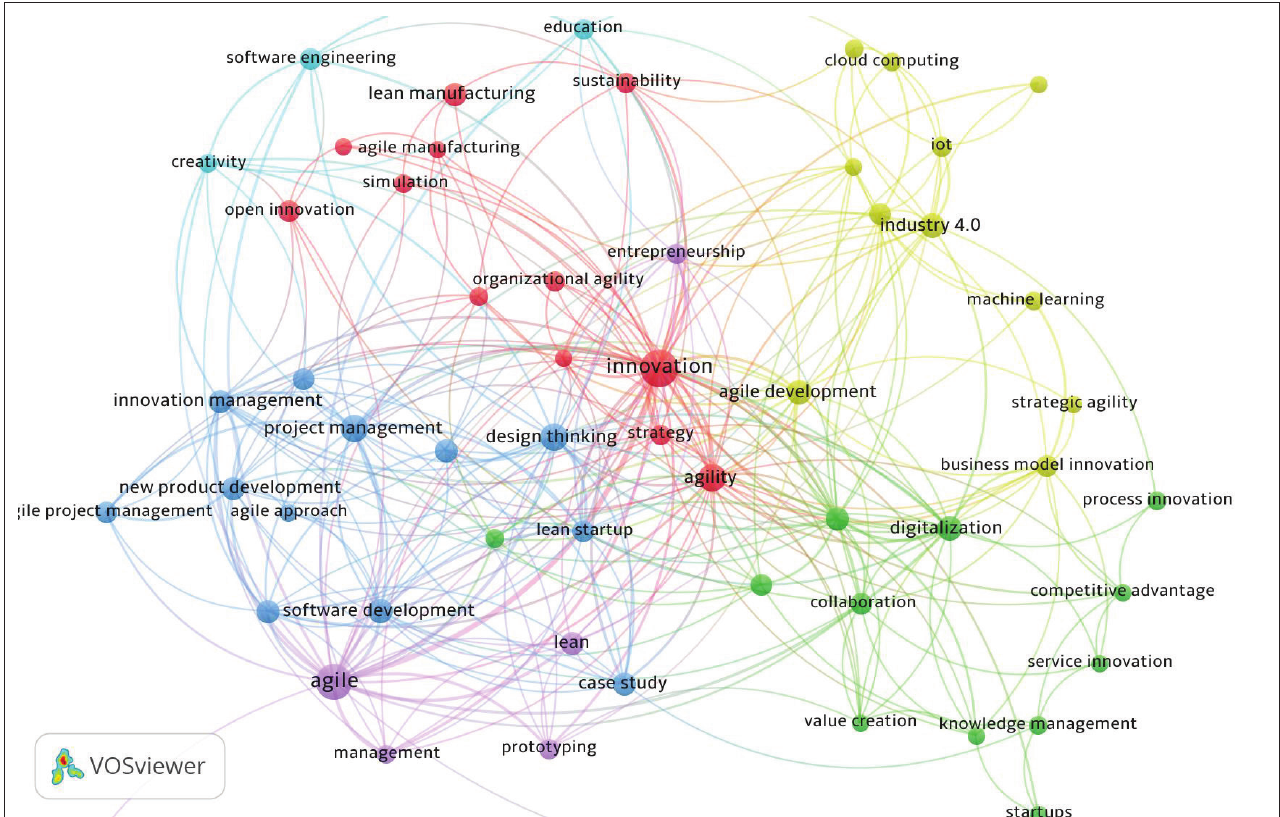
FIGURE 3: Keyword co-occurrence